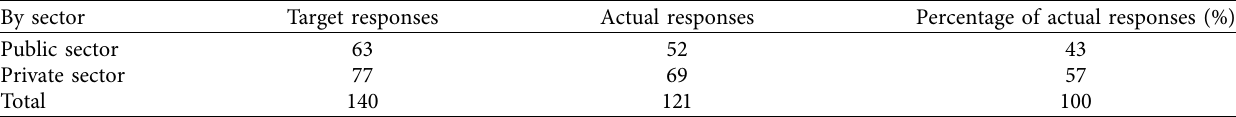
Table 2: Questionnaire respondents’ distribution.